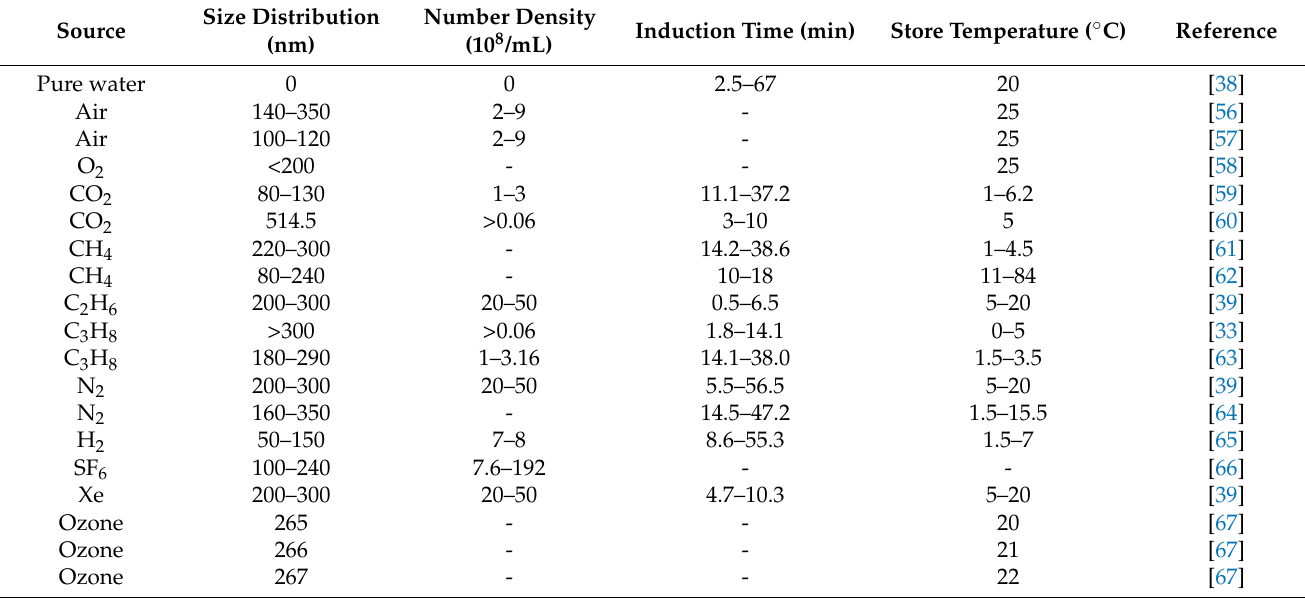
Table 1. Different MNBs to promote hydrate